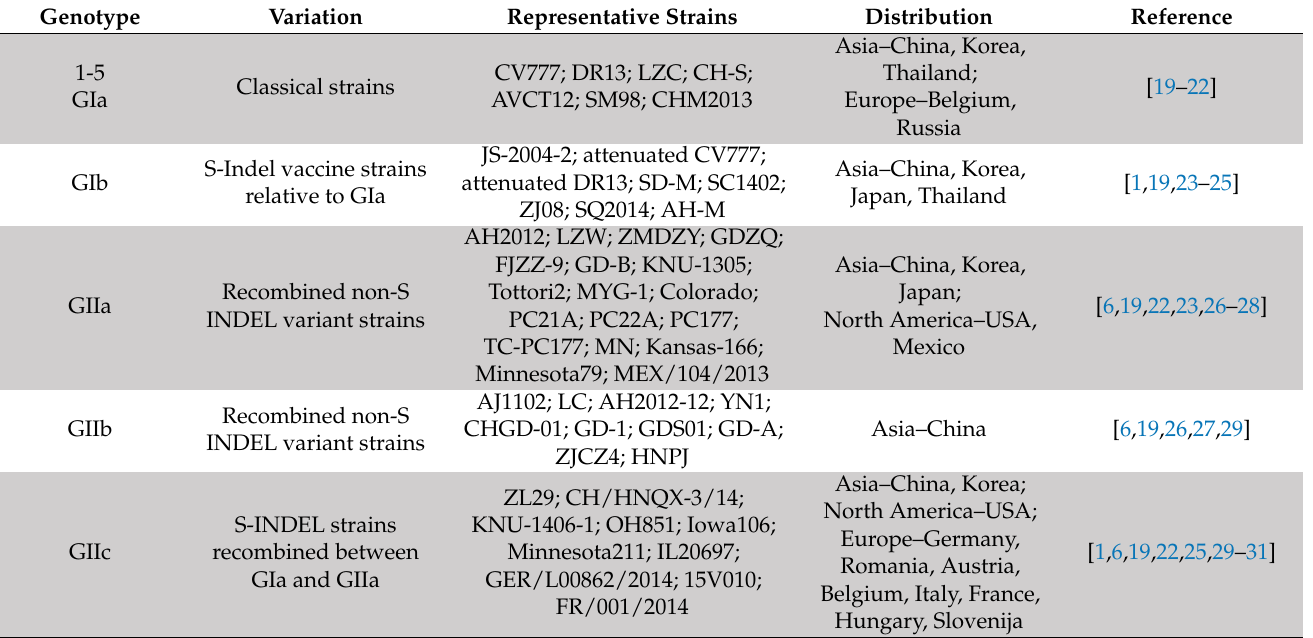
Table 1. Representative strains and distributions of each PEDV